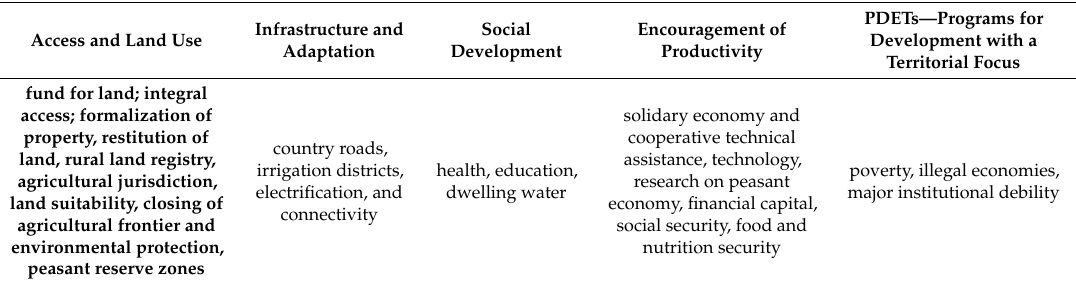
Table 1. Components of the Integrated Rural Reform, part one of the Colombian peace agreement between the government and